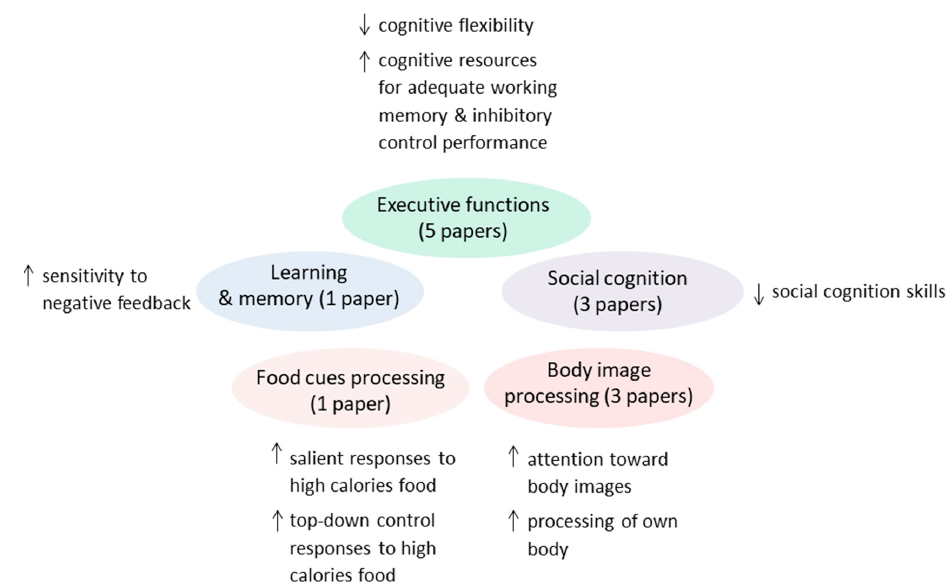
Figure 3. Main conclusions from the reviewed papers. The figure summarizes the main conclusions drawn from the authors of the reviewed papers ( n = 12), relative to each cognitive domain. The findings are further discussed in the Results section.